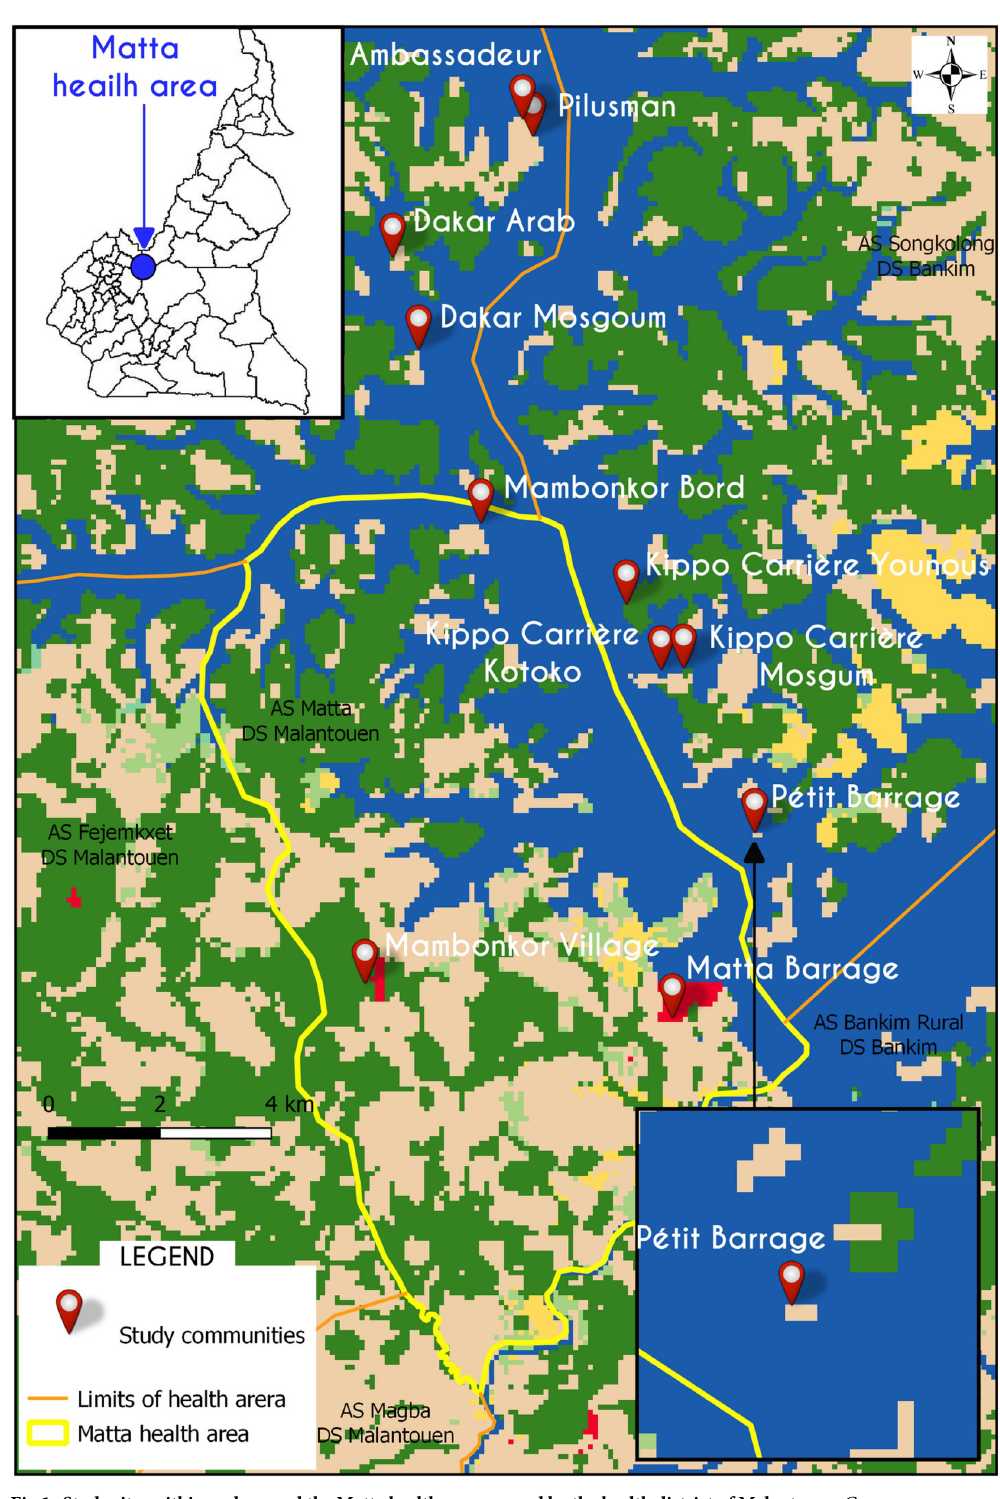
Fig 1. Study sites within and around the Matta health area covered by the health district of Malanteoun. Cameroon map showing the location of the Matta health area. Excerpt of Petit Barrage community, an example to show the remoteness and water enclosed nature of communities, only accessible through boats (fishing boats). Source data: Map base layer is from the Esri 2020 Land Cover map (https://arcg.is/0Kemuy).This dataset is available under a Creative Commons BY-4.0 license and any copy of or work based on this dataset requires the following attribution: This dataset is based on the dataset produced for the Dynamic World Project by National Geographic Society in partnership with Google and the World Resources Institute.Health boundaries from the Ministry of Public Health Cameroon (https://www.minsante.cm/);GPS coordinates collected during field survey.